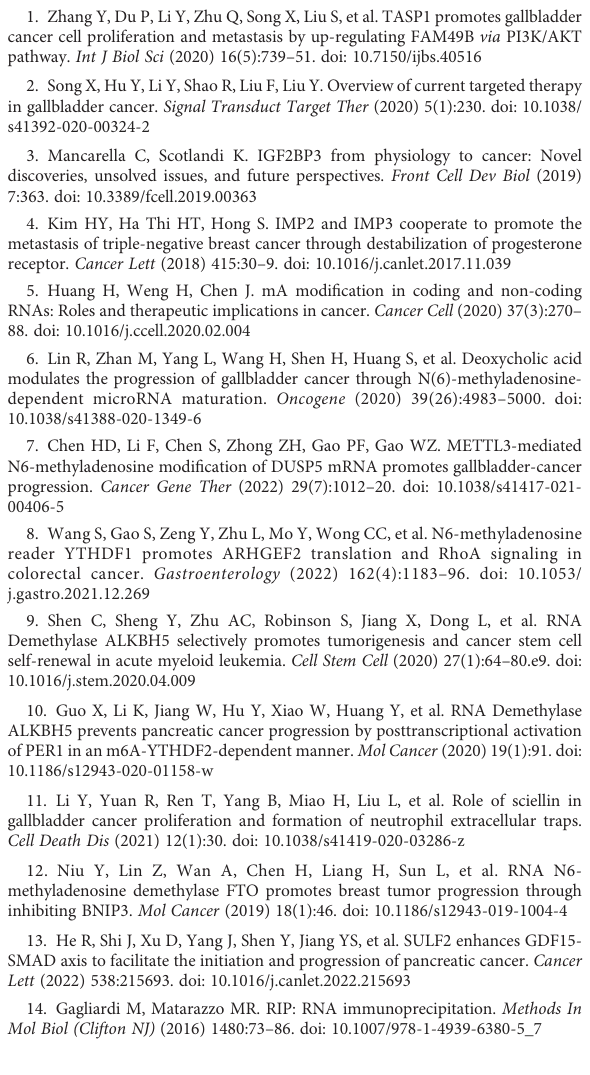
SUPPLEMENTARY FIGURE 2 Statistical analysis of the results from transwell assays. SUPPLEMENTARY FIGURE 3 Gel electrophoresis showing the result of RIP-qPCR. SUPPLEMENTARY FIGURE 4 Western blotting of downstream pathway targets in GBC cells with IGF2BP3